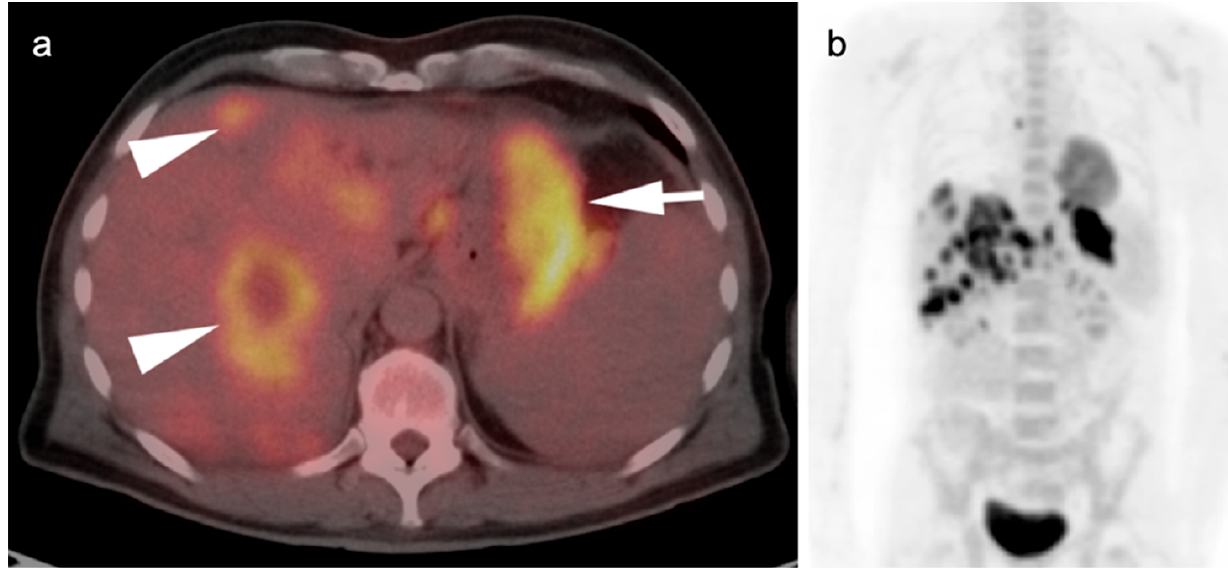
Figure 8. Metastatic gastric cancer. ( a ) Axial FDG PET-CT and ( b ) MIP image. Markedly hypermetabolic in gastric carcinoma (white arrow) with widespread hepatic metastases (white arrow- heads).